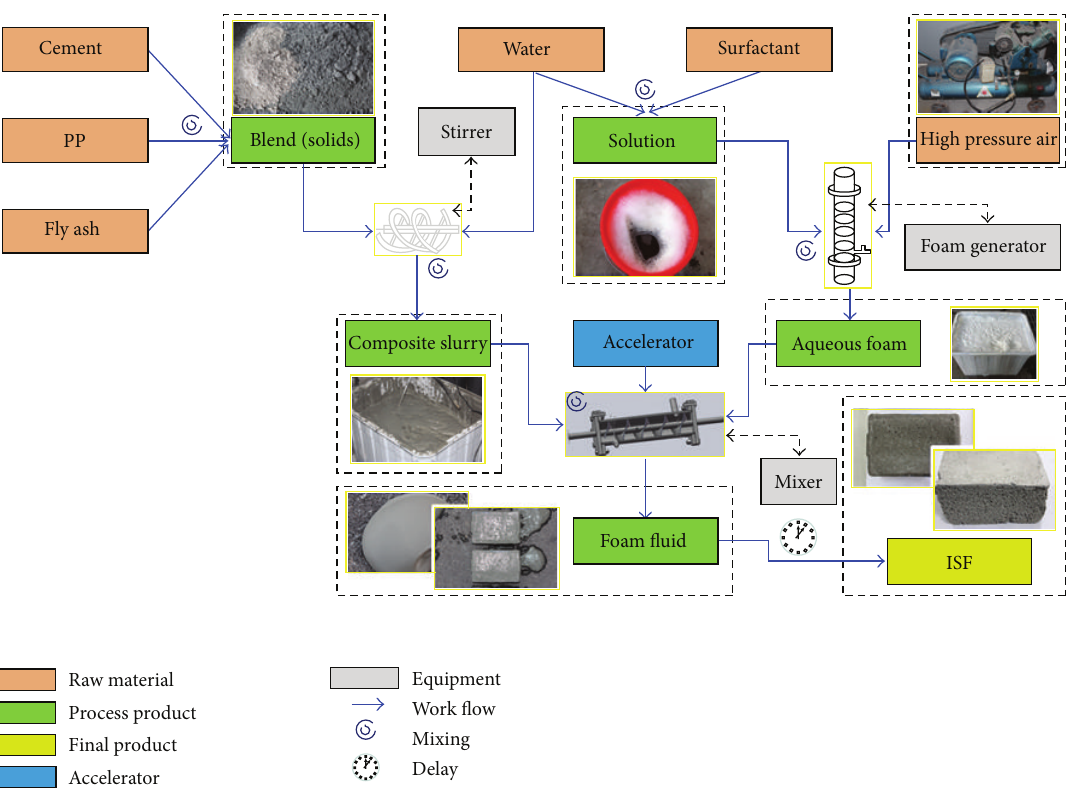
Figure 1: The schematic of the preparation of ISF.